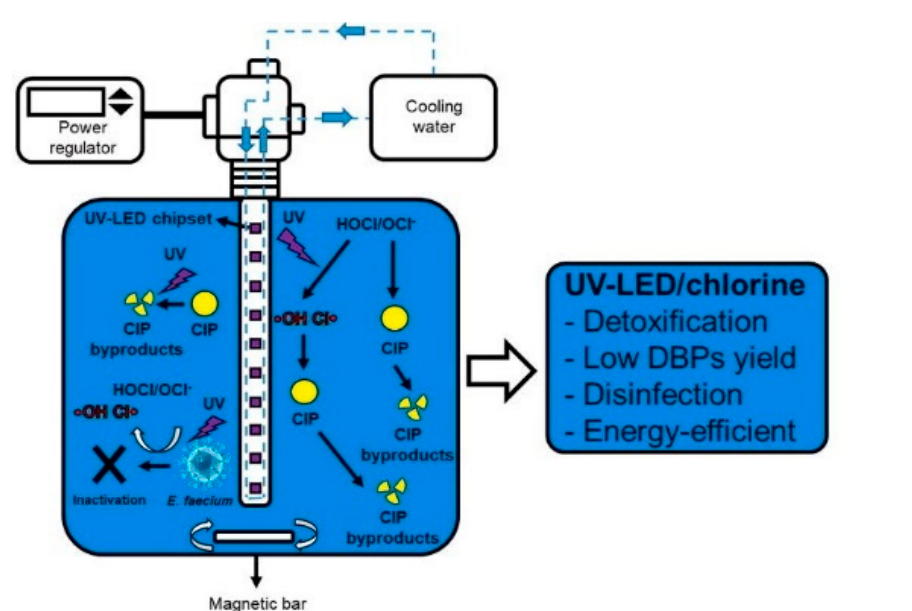
Figure 4. Schematic diagram of UV-LED reactor. Reprinted with permission from ref. [52]. Copyright 2020 Elservier.